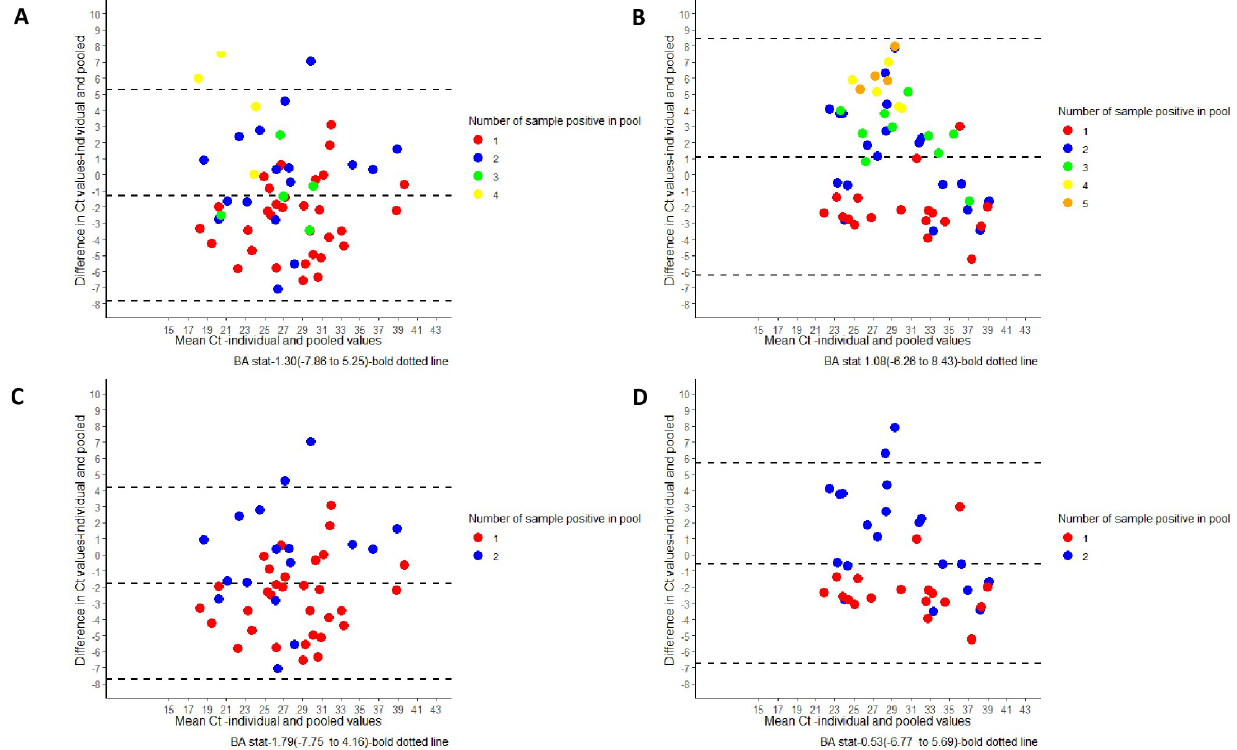
Fig 1. Bland-Altman plot showing the relative positions of Ct values of pooled values in reference with individual Ct and bias estimates between (A) 4-sample pools and (B) 5-sample pools, (C) 4-sample pools with 1 and 2 positives samples and (D) 5-sample pools with 1 and 2 positives samples. Colored dots represent the number of positive samples in a